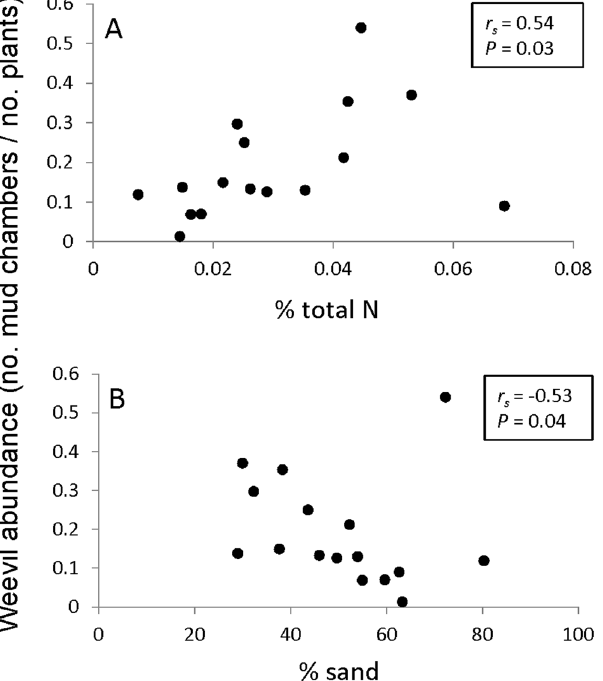
Figure 3. Relationships between soil parameters (averaged per field site) and weevil abundance. Weevil abundance was positively related to soil nitrogen and negatively related to % sand in the soil (see text for details).